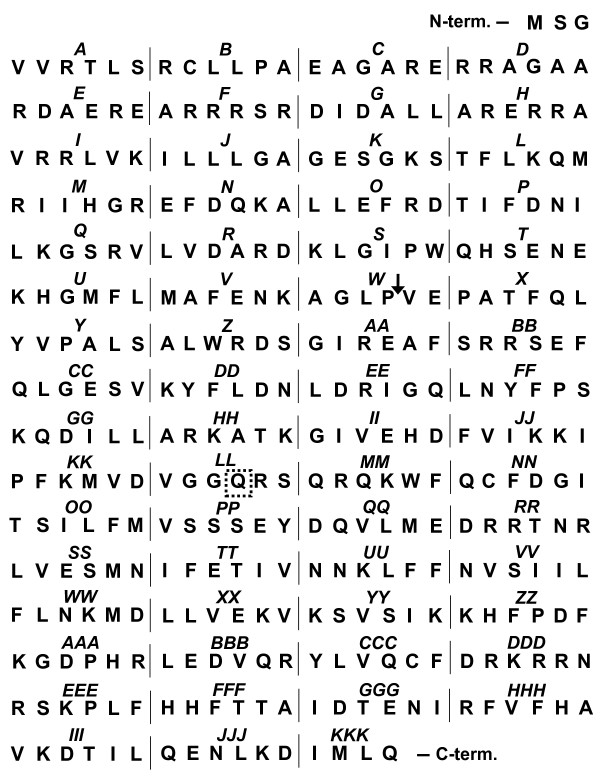
Residues replaced in Gα12 cassette mutants. For each mutant, designated in italics (A-Z, AA-ZZ, AAA-KKK), the native amino acid sextet replaced by the sequence Asn-Ala-Ala-Ile-Arg-Ser is shown. An arrow between Pro139 and Val140 indicates the site of myc tag insertion. Mutant W was not produced. The dashed box indicates the native Gln229 mutated to Leu to render Gα12 constitutively active. The native residues replaced in mutant KKK are Lys-Asp-Ile-Met-Leu-Gln and thus partially overlap with mutant JJJ. All cassette mutants contain the activating Q229L mutation, except mutant LL due to its cassette substitution.